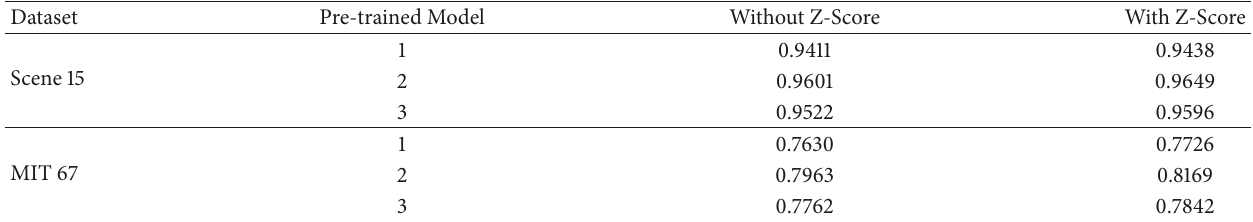
Table 3: Results of scene classification with or without Z-Score normalization.